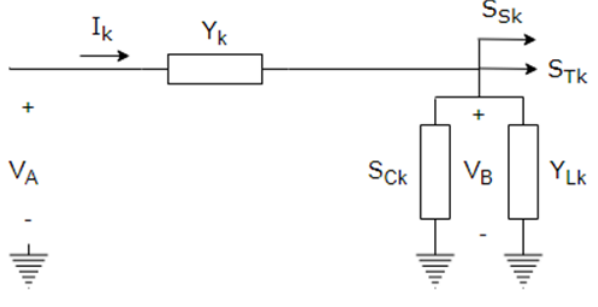
Figure 1. Kth circuit element.